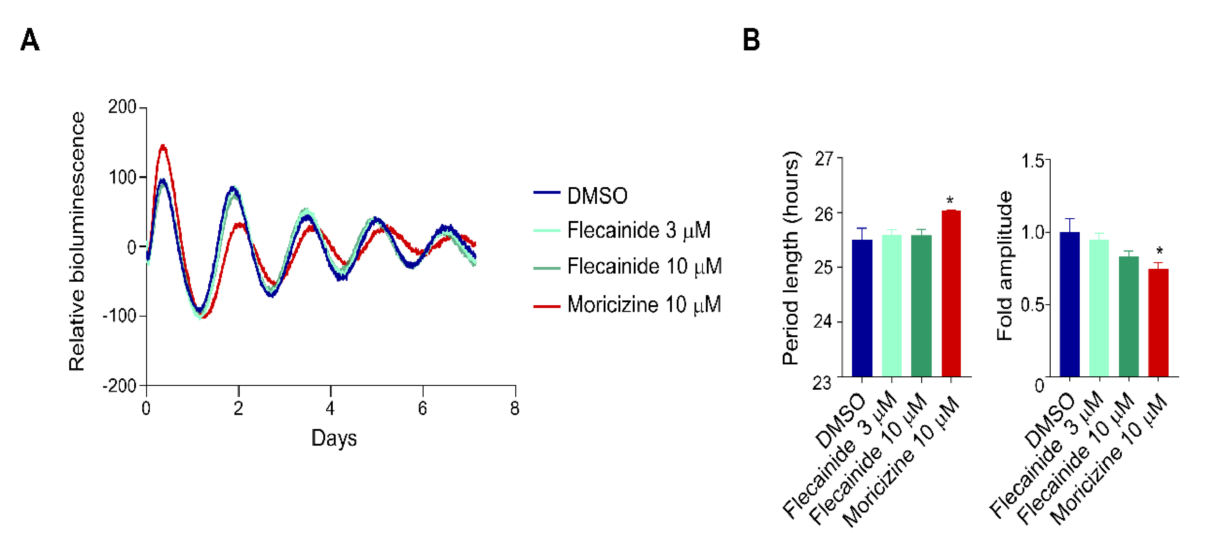
Figure 2. Flecainide does not affect circadian reporter rhythms. ( A ) Representative PER2::LUC bioluminescence recording of Per2::LucSV fibroblast cells treated with Figure 3. or 10 µ M) or moricizine (10 µ M). ( B ) Average circadian period lengths and amplitudes are shown ( n = 3–4 for each concentration). Data are presented as mean ± SEM. T -test shows significant statistical differences between DMSO and flecainide or moricizine. (*, p <